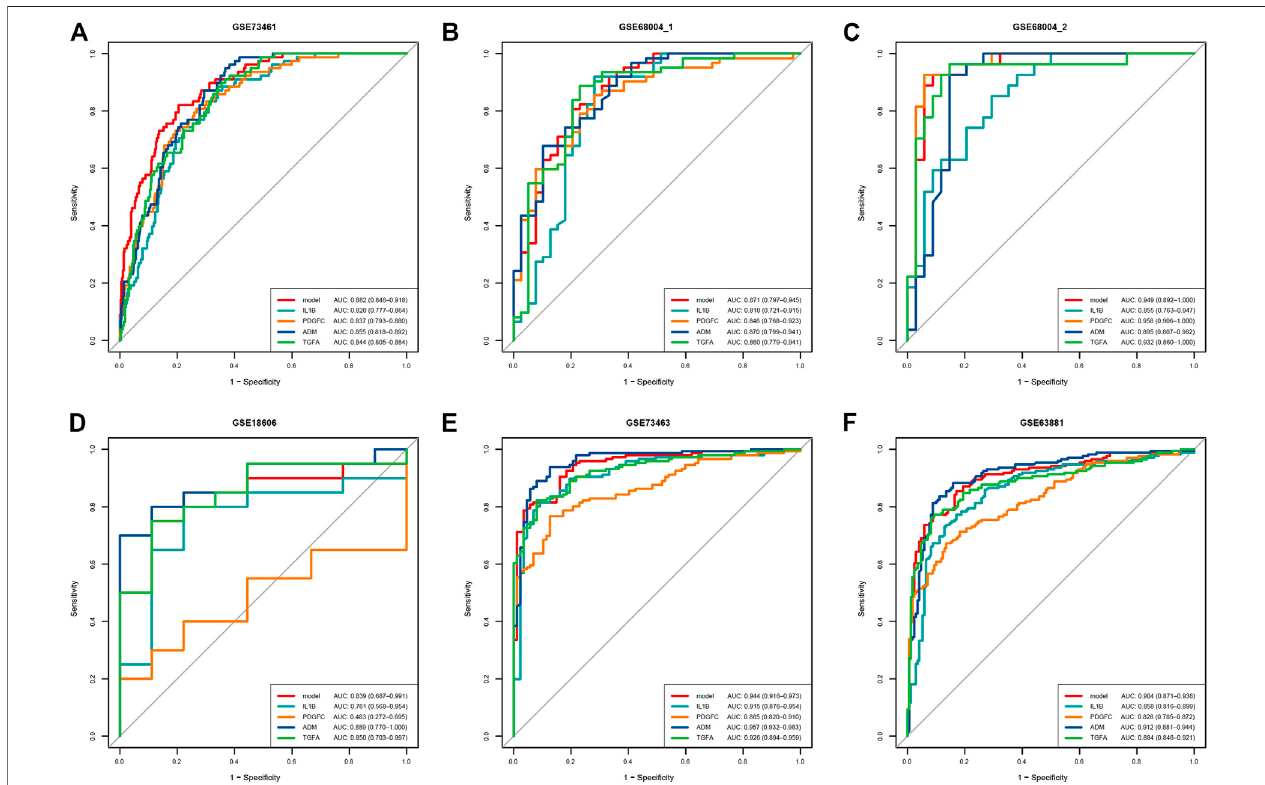
FIGURE5| ROCcurveofthepredictiveef fi cacyveri fi cationofthesinglediagnosticmarkerand4-genediagnosticmodel. (A) ROCcurveoftrainingset. (B – D) ROC curve of veri fi cation sets, each dataset contains acute KD and non-KD samples. (E,F) ROC curve of veri fi cation sets, each dataset contains acute KD and convalescent KD